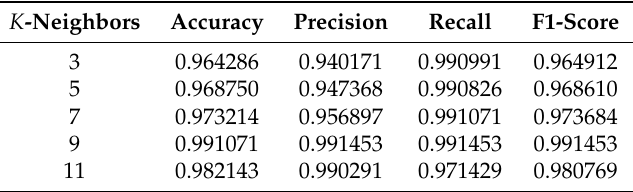
Table 8. Performance of k-Nearest-Neighbor